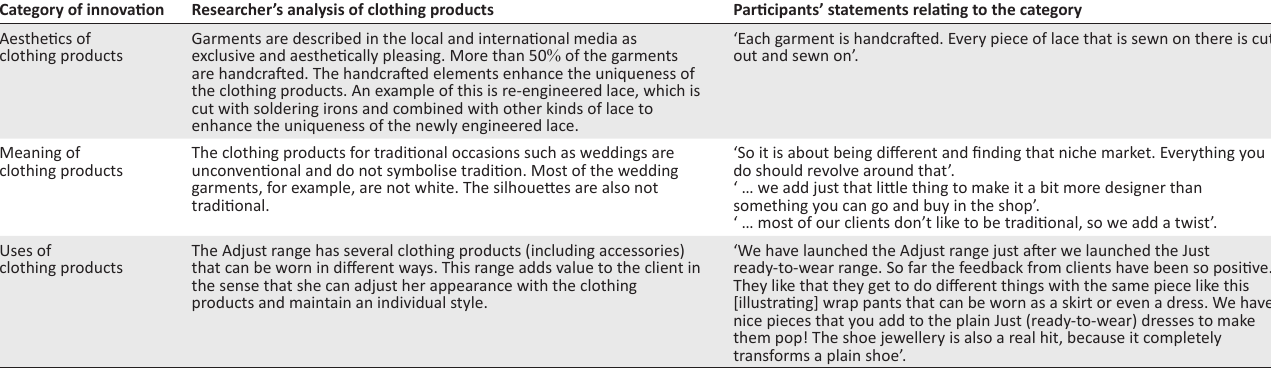
TABLE 2: Product innovation resulting from collective creativity. Category of